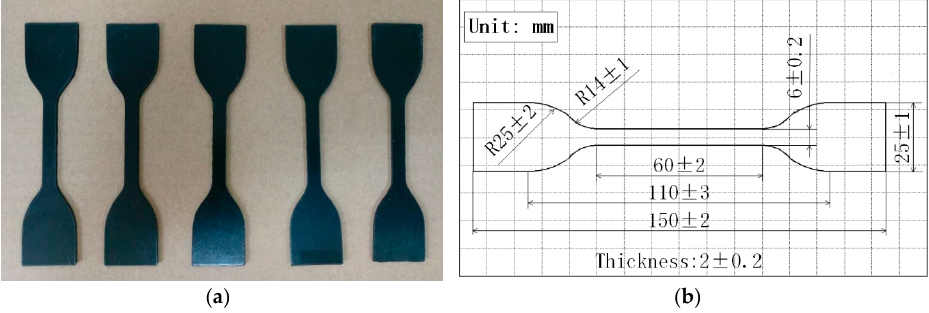
Figure 3. The rubber samples: ( a ) shape of samples; ( b ) dimension of samples.